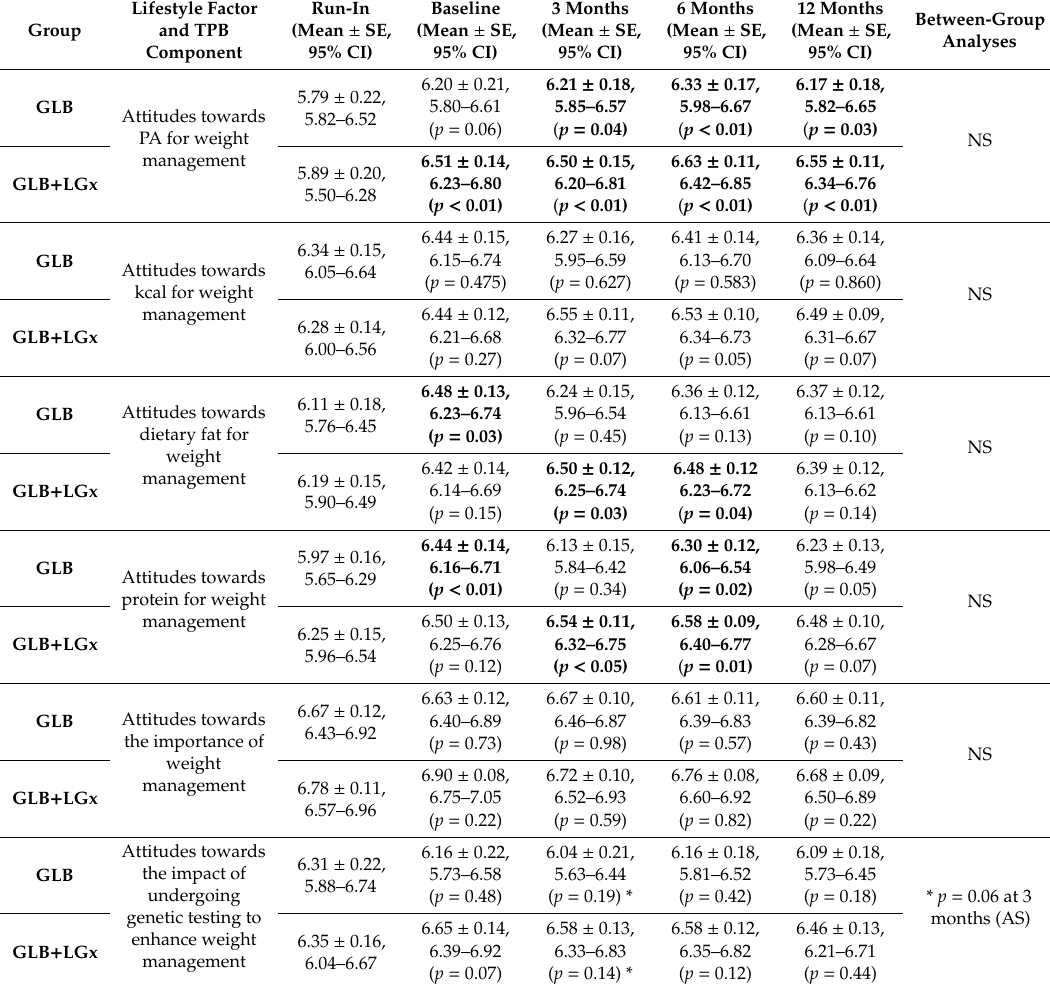
Table 1. Change in attitudes by intervention group over 12-month